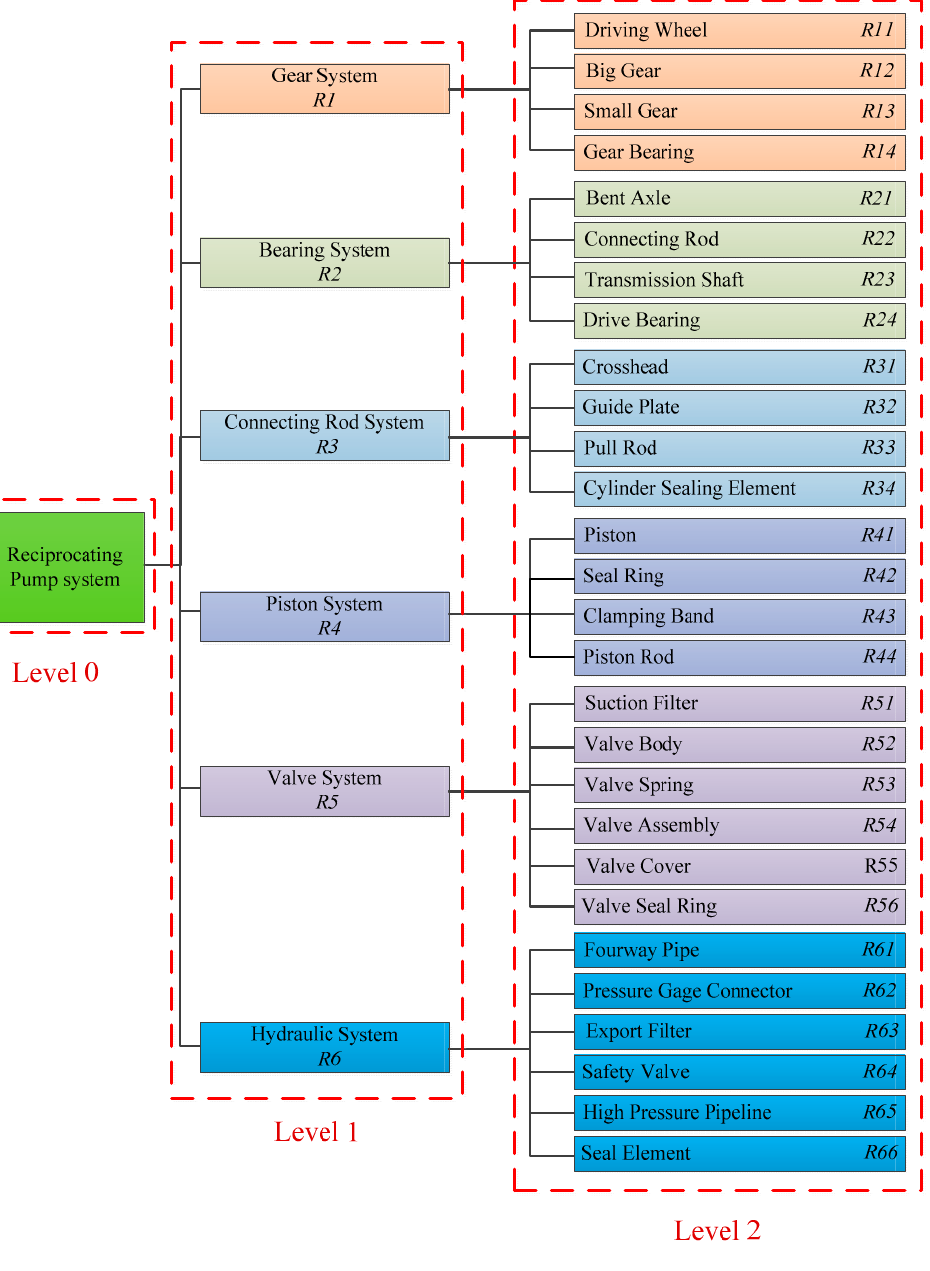
Figure 6. The hierarchical structure tree (HST) of the reciprocating pump system (RPS)